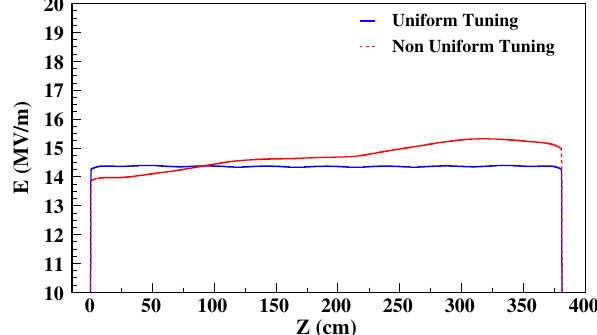
FIG. 8. Uniform and nonuniform tuning effect on the intervane field along the